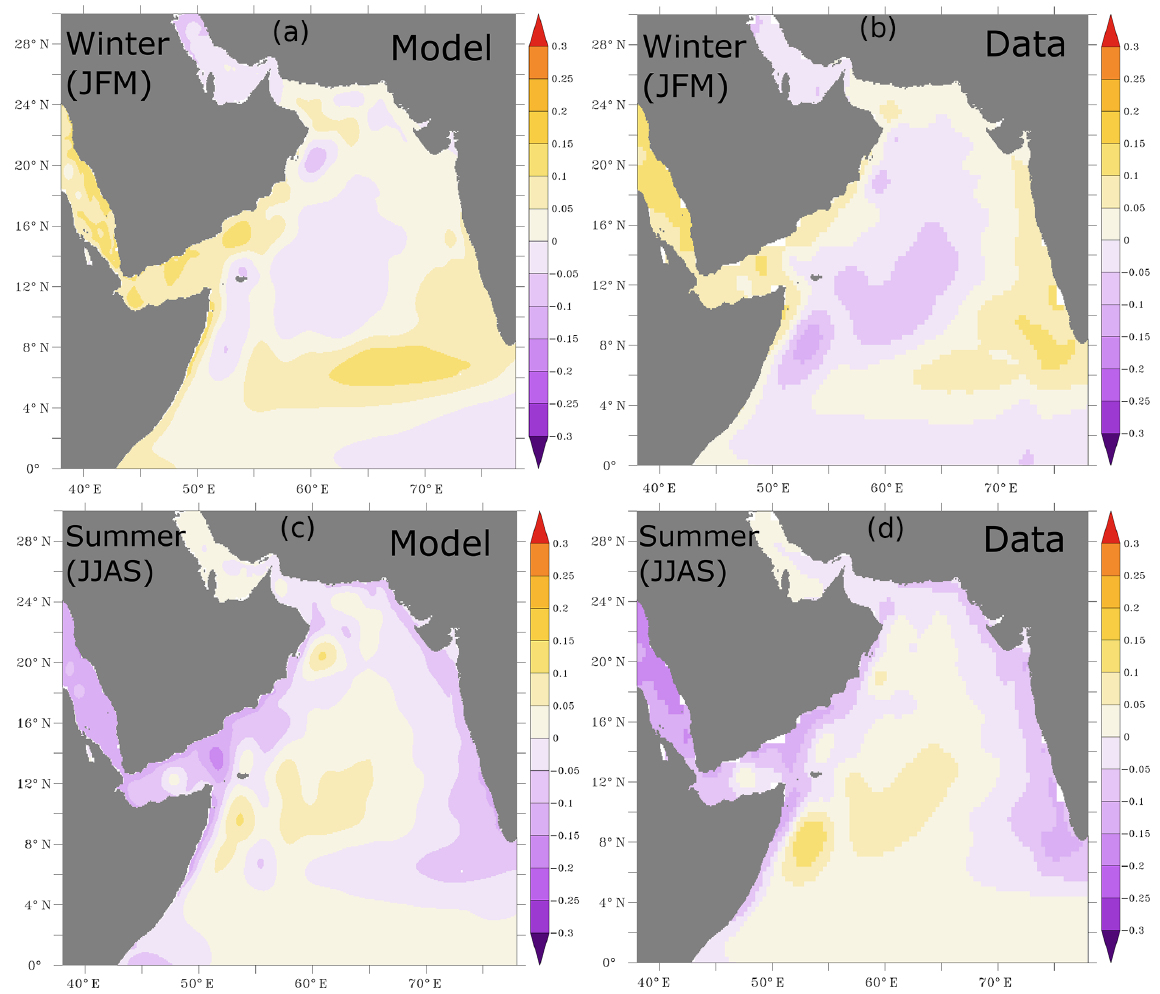
Figure A2. Sea surface height anomalies. Sea surface height seasonal anomalies (in meters) simulated in ROMS (a, c) and from AVISO (b, d) during winter (a, b) and summer (c, d) months. The AVISO climatology is computed over the period from 1993 to